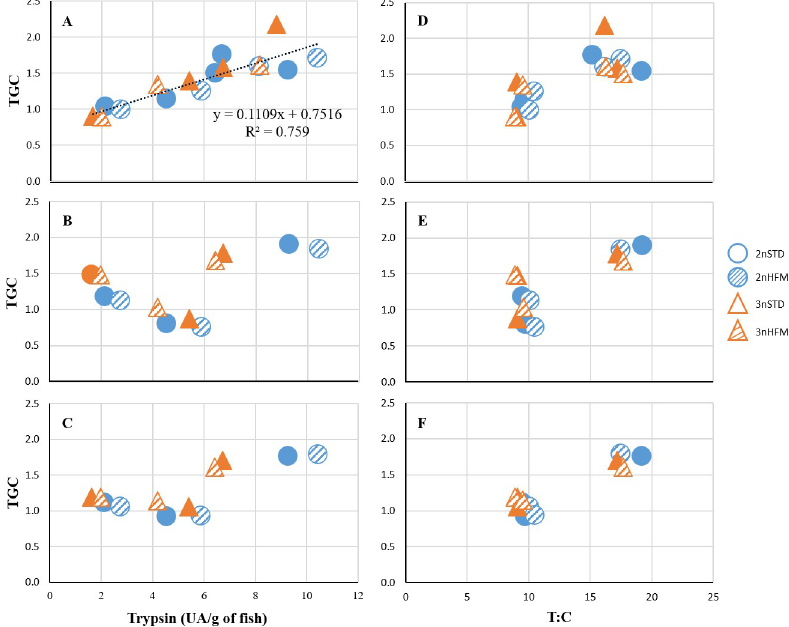
Fig 13. Relationship between TGC and trypsin activity or trypsin-to-chymotrypsin ratio (T:C). TGC data and specific activity of trypsin (A-C) activity (expressed as UA/g of fish) and trypsin-to-chymotrypsin (T:C) ratio (D-F) recorded in the intestine of diploid and triploid fish fed fish meal (STD) and hydrolysed fish protein (HFM) diets in the period (A,D) prior to sampling, (B,E) after sampling and (C,F) in whole timeframe.